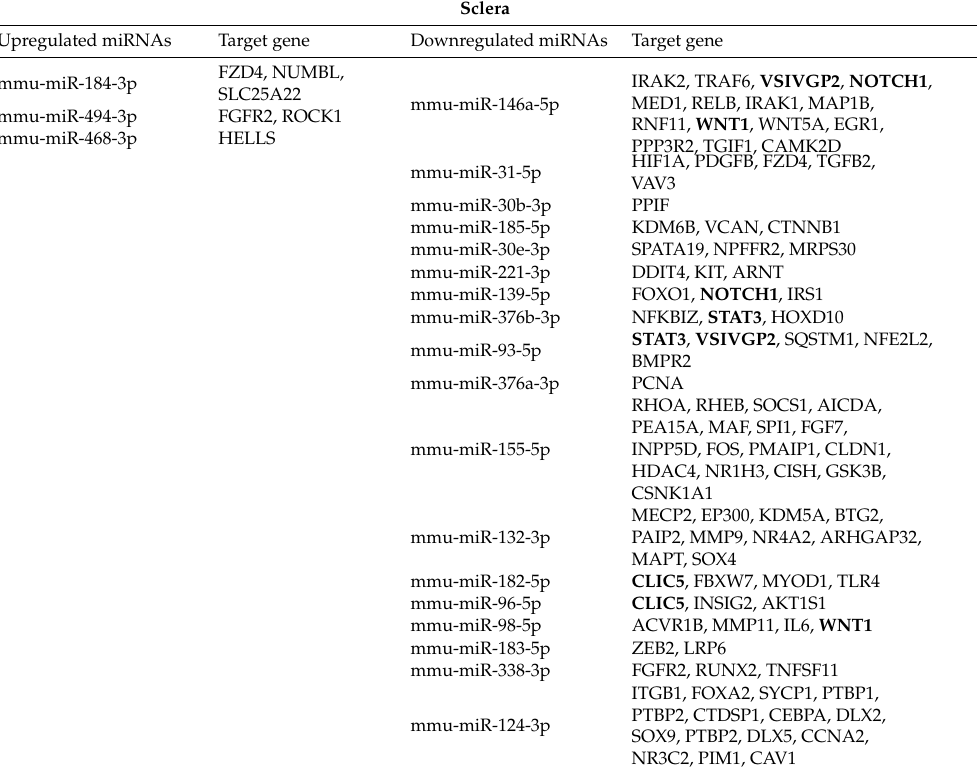
Table 12. The target genes predicted from the change in miRNA expression in the